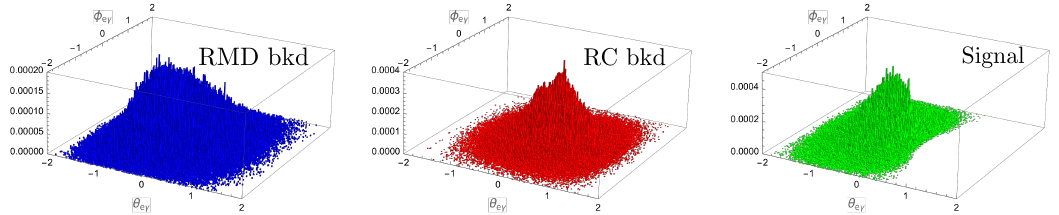
Figure 8 . The unit-normalized distributions of RMD (Left), RC (Middle) background and signal (Right) events on the ( θ eγ , φ eγ )-plane for the benchmark point of the dedicated run ( ? in figure 1) with the bin size of 20mrad ( θ eγ ) × 20mrad ( φ eγ ) up to modulo of 2 π for φ eγ . For the signal we took m a = 10 − 4 MeV.